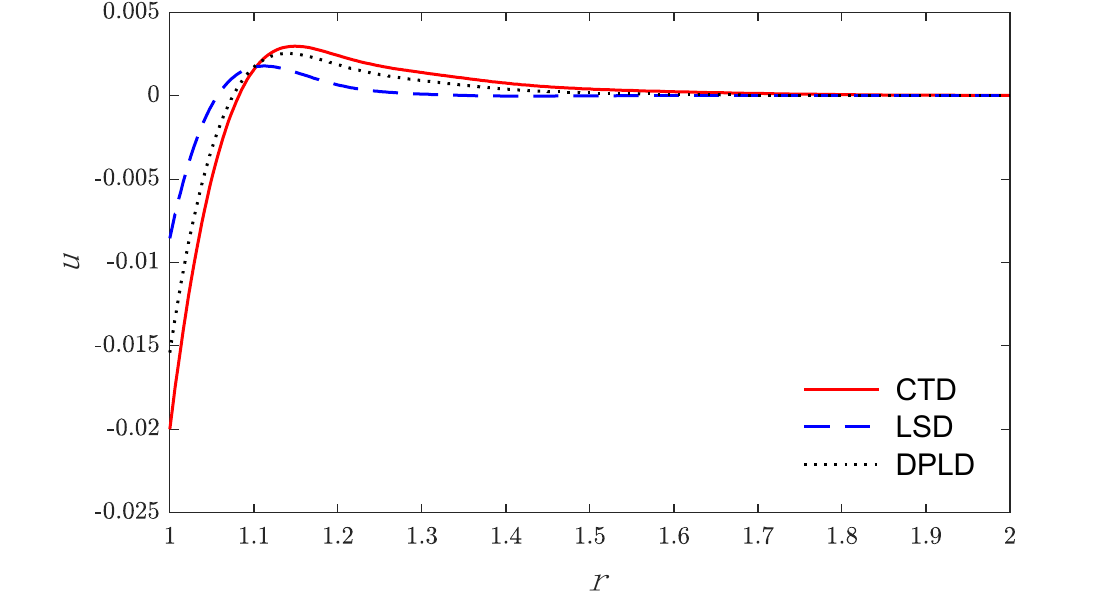
Figure 2. The redial displacement variations 𝑢 versus the redial distance 𝑟 for three models .